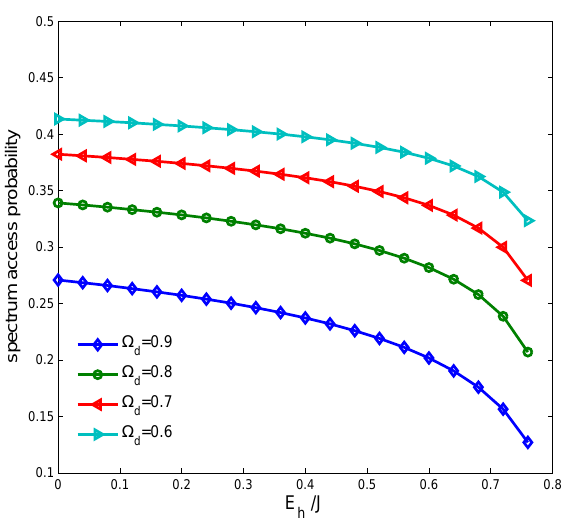
Figure 14. Spectrum access probability vs. cooperative detection probability with harvested